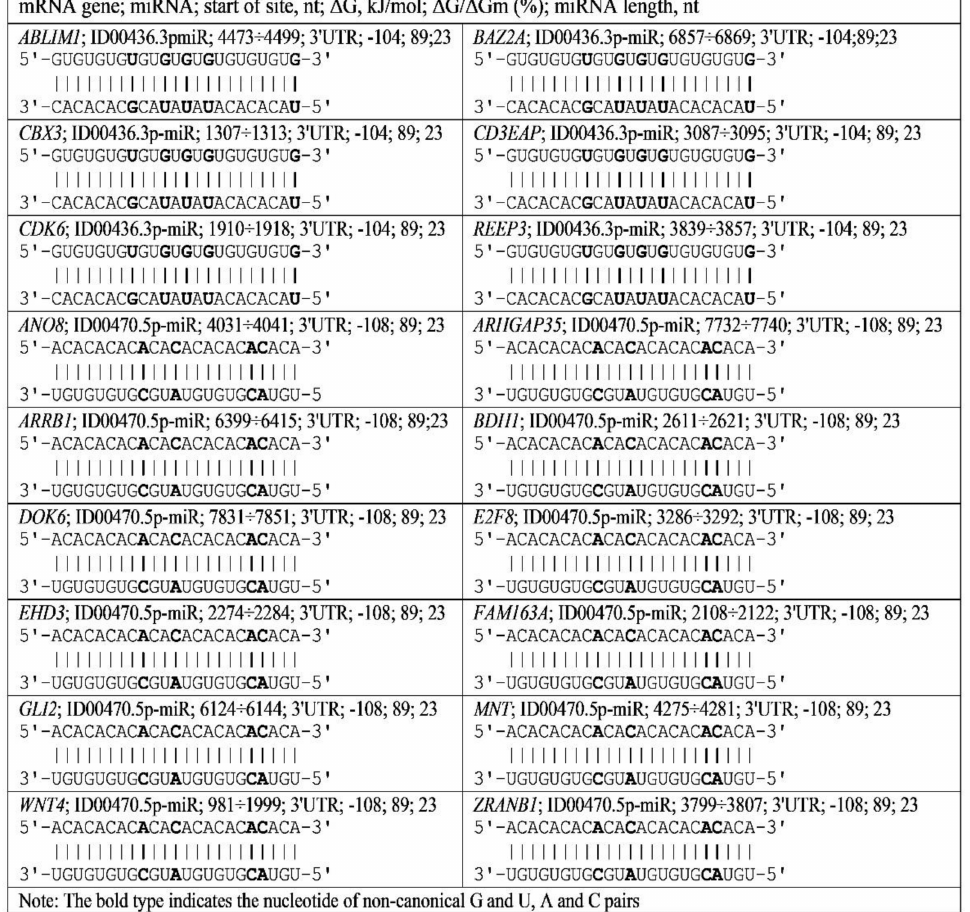
Figure 3. Schemes of ID00436.3p-miR and ID00470.5p-miR binding with mRNAs of genes having GU and AC nucleotide